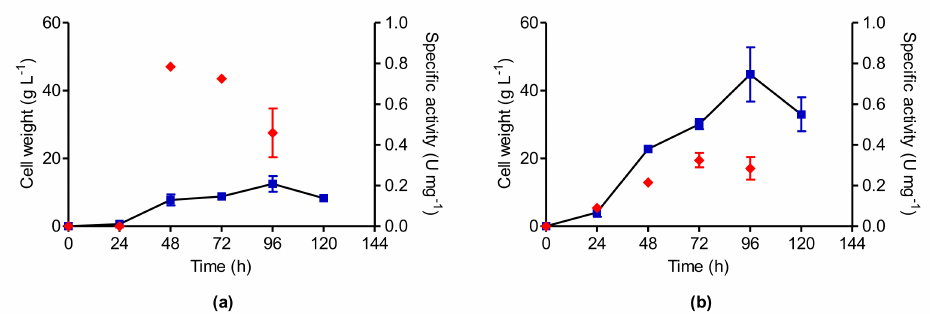
Figure 5. Variation of biomass ( (cid:4) ) after 120 h and L -asparaginase specific activity ( (cid:7) ) after 96 h of incubation at 32 ◦ C and 120 rpm: ( a ) P. sizovae ; ( b ) F. proliferatum . Results are presented as mean ± standard